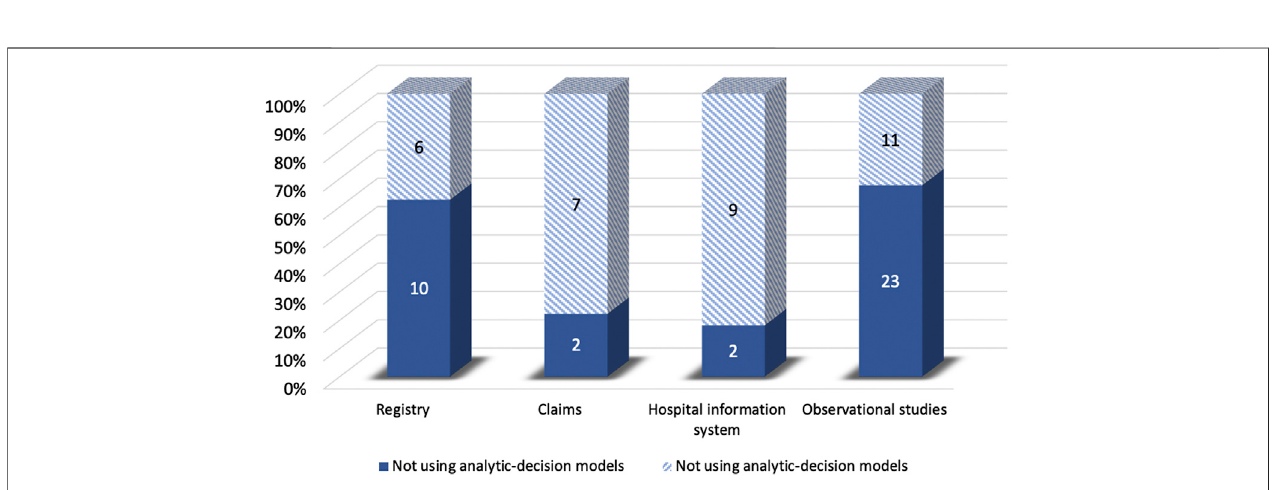
FIGURE 5 | Differences in effectiveness sources between real-world cost-effectiveness analysis with or without decision-analytic model.